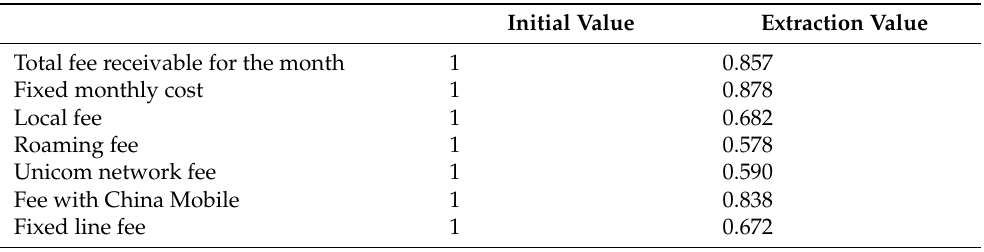
Table 6. Common factor variance results—adapted from Zhang [6].